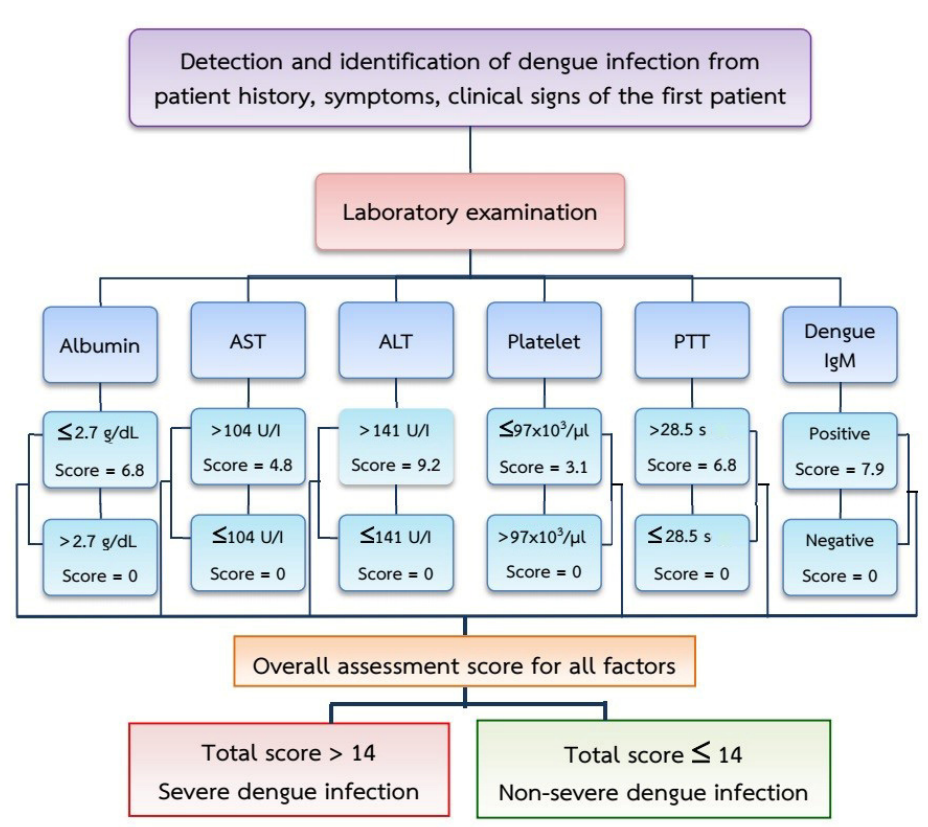
Figure 2. Diagram of procedures for the classification of disease severity with a simple method for detecting and identifying severe dengue infections .